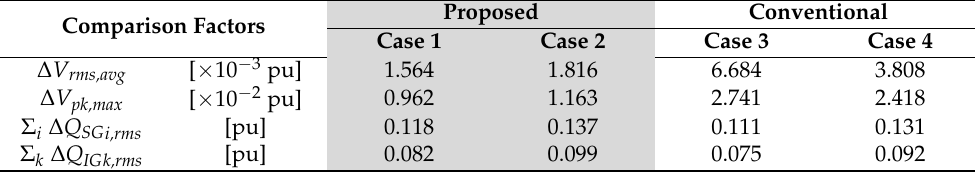
Table 10. Comparisons for the continuous load